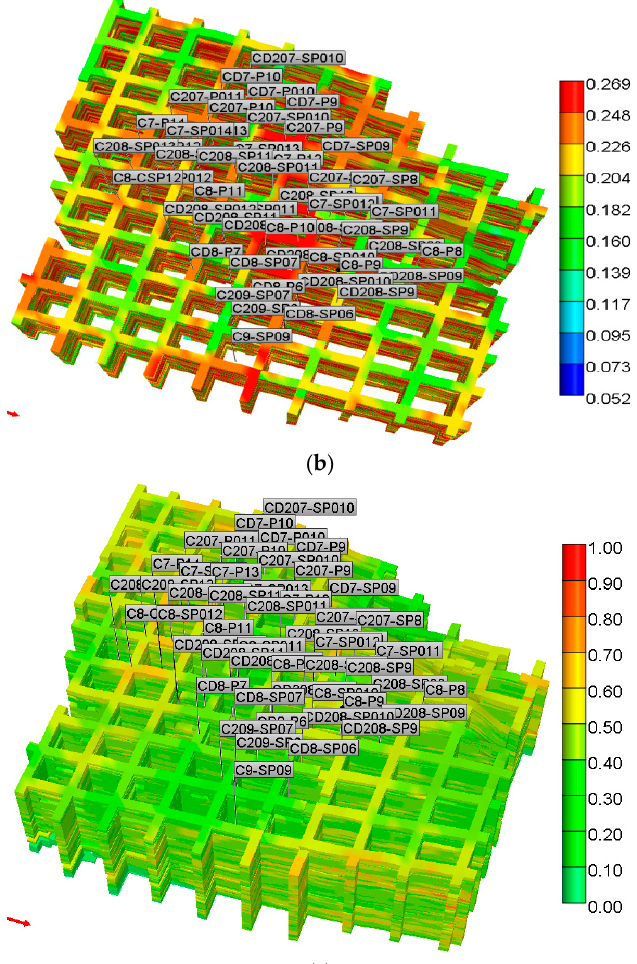
Figure 1. Different models. ( a ) Permeability model; ( b ) porosity model; and ( c ) oil saturation model.